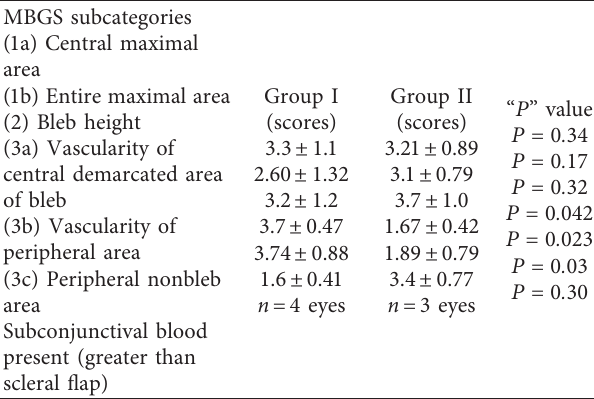
Table 6: MBGS scores and “ P ” values for all subcategories at one- year follow-up.